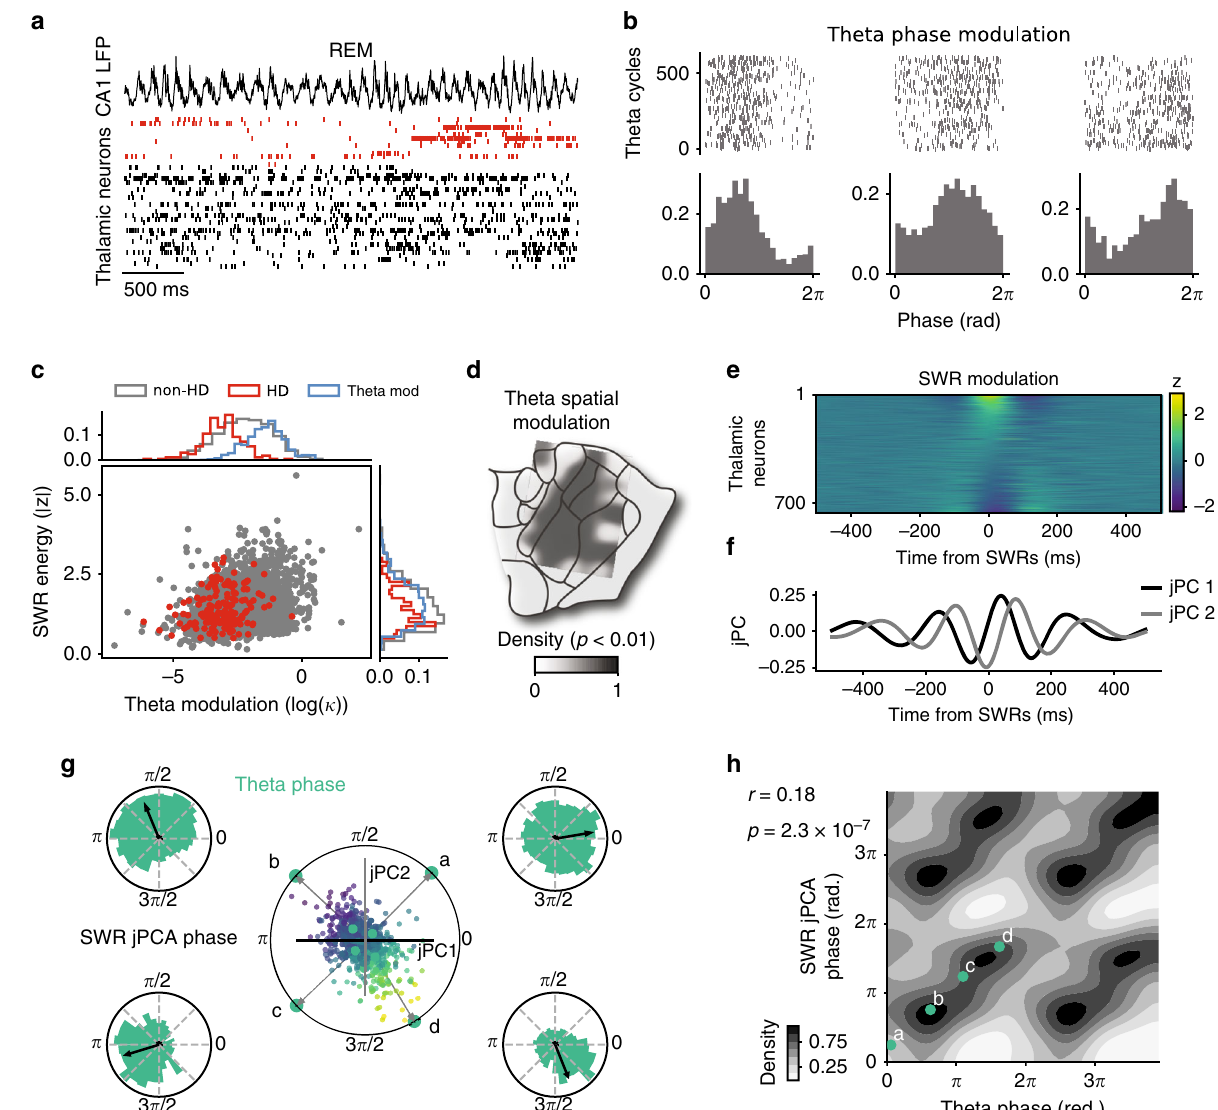
Fig. 3 Relationship between temporal coupling of AT neurons to SWRs and modulation by theta oscillations. a Example of a simultaneous recording of LFP in the CA1 pyr. layer (top) and neuronal activity in the AT (bottom) during REM sleep. Red ticks indicate spikes from HD neurons, sorted according to their preferred direction during wakefulness. b Top, spikes for successive theta cycles. Bottom, histograms of spike density within theta cycles for three example neurons during REM sleep. c Theta modulation versus SWR energy for all neurons (red points indicate HD neurons). Side panels indicate distribution of each group. “ Theta mod ” (blue distributions) indicates the group of neurons signi fi cantly modulated by theta ( p < 0.01). d Density map of theta-modulated neurons (min = 0.016) for one mouse. Note the absence of theta modulation for AD. e Z -scored SWR cross-correlograms for all theta- modulated AT neurons (equivalent to the group theta-mod in c ). Neurons are sorted according to their modulation at SWR peaks. f First two jPC vectors (black and gray) of SWR cross-correlograms. g Projection of individual SWR cross-correlograms onto the fi rst two jPCs. Point colors indicate 0-lag modulation (same color code as in e ). Gray arrows indicate corresponding SWR-jPCA phase for four example neurons (green points, a-d). Theta phase distributions for the same four neurons are shown at each corner. h SWR-jPCA phase as a function of theta phase ( r = 0.18, p < 0.001, circular correlation). The four example neurons are shown in